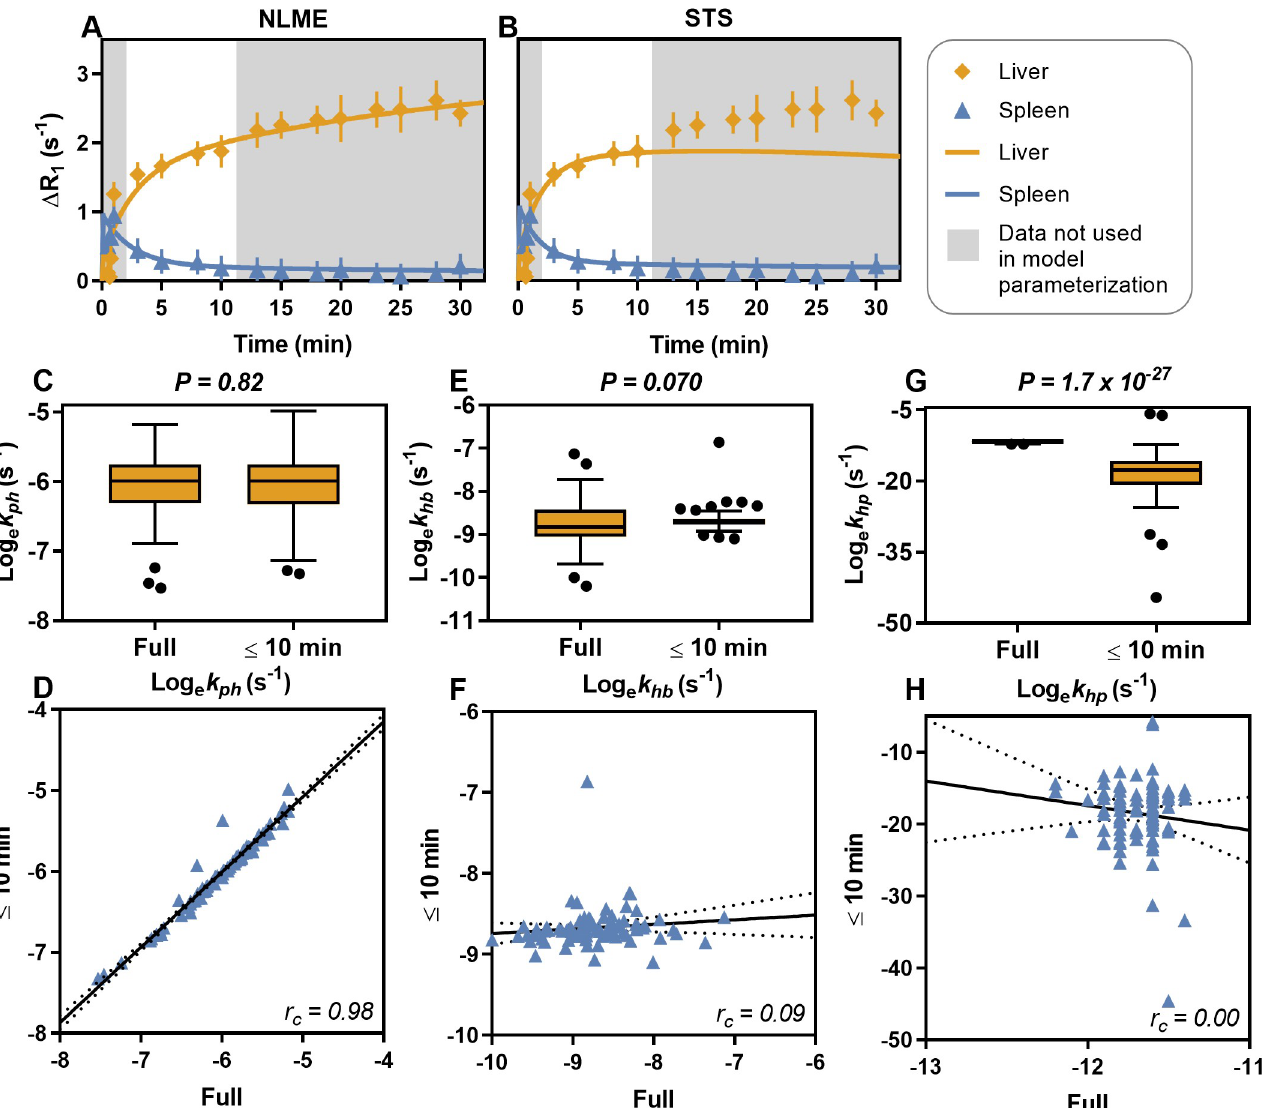
Fig 3. The non-linear mixed effects (NLME) model parametrization enables shorter gadoxetate MRI examinations. The models were parametrized with data up to 10 min after gadoxetate injection and were validated against the remaining data. ( A ) shows an example of simulation after NMLE parameterization, ( B ) shows a simulation of the same patient after STS parameterization. The natural logarithms of the model parameter values hepatocyte uptake rate (k ph ; C-D ), hepatocyte elimination rate (k hb ; E-F ), and hepatocyte to plasma flux (k hp ; G-H ), estimated with the NLME method using the full data set, were compared with the parametrization using data up to 10 minutes. Significant differences were observed for k hp . The solid line is a linear regression and the dotted lines are 95% confidence